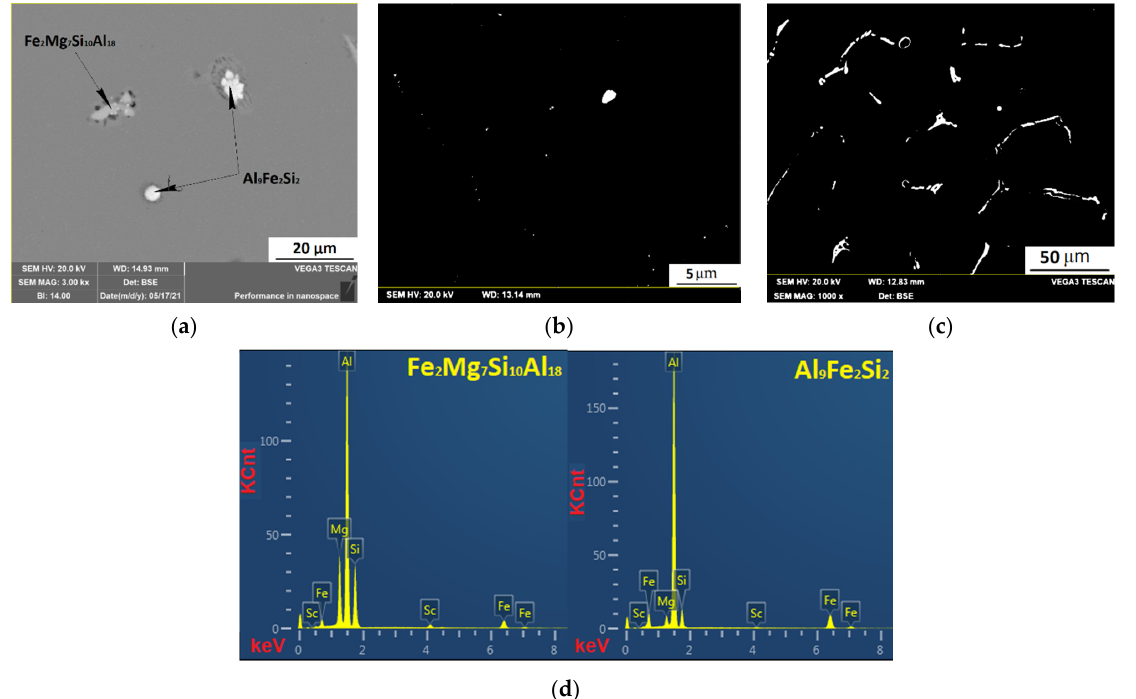
Figure 6. Al 0.3 Mg 1 Si 0.3 Sc main types of intermetallic compounds ( a ); small dispersoids ( b ); large particles ( c ); result of the energy-dispersive spectroscopy (EDS) investigation of chemical composition of the intermetallic compounds ( d ).